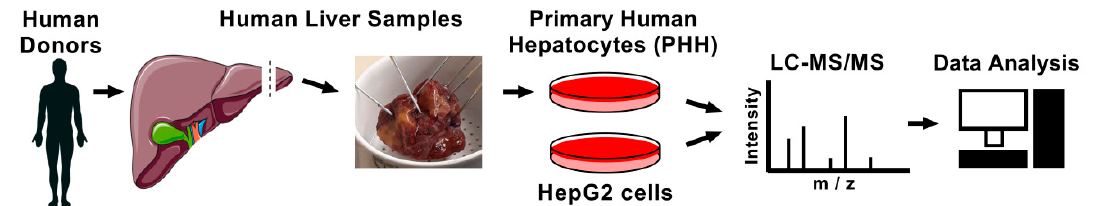
Figure 1. Flow-chart work scheme. Primary human hepatocytes (PHH) were isolated from four human donors. FBS-free condition media were collected from PHH, as well as HepG2 cells, and samples were loaded onto SDS-PAGE, and proteins were in-gel digested. Peptides were separated and measured with liquid chromatography coupled to tandem mass spectrometry. Data were analyzed with MaxQuant.